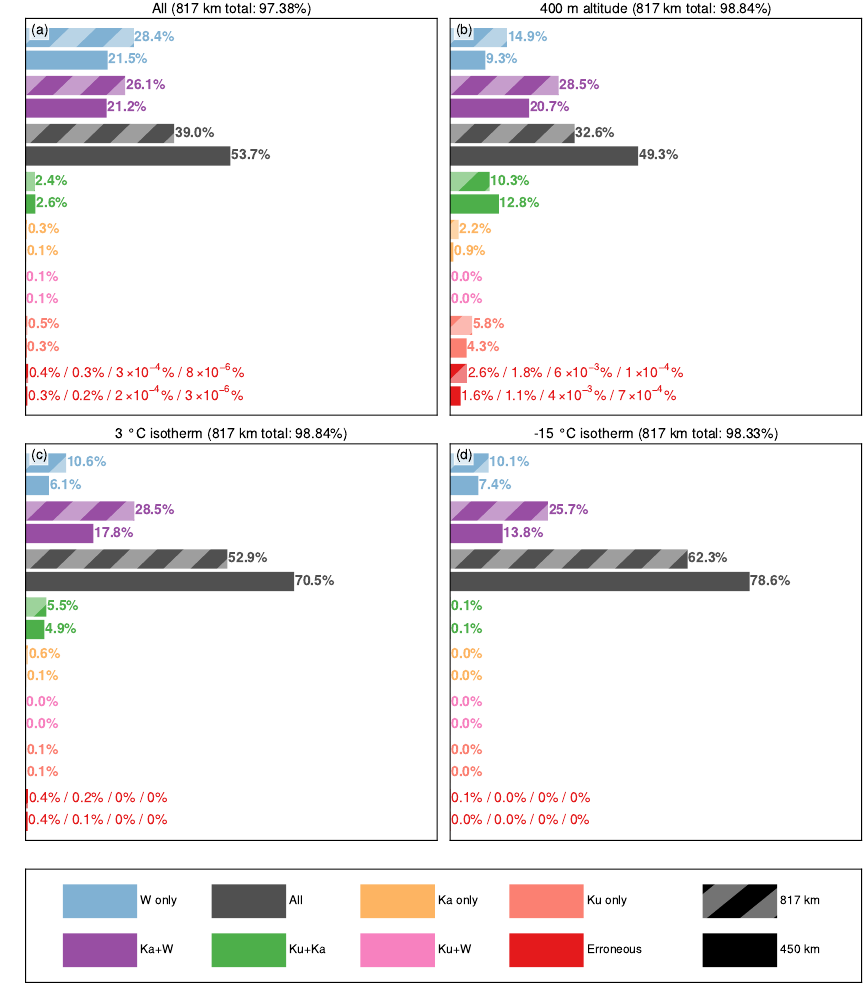
Figure 11. As in Fig. 4, but limited to the region of Fig. 10 (Sect. 5.4; CYC in Fig. 3).